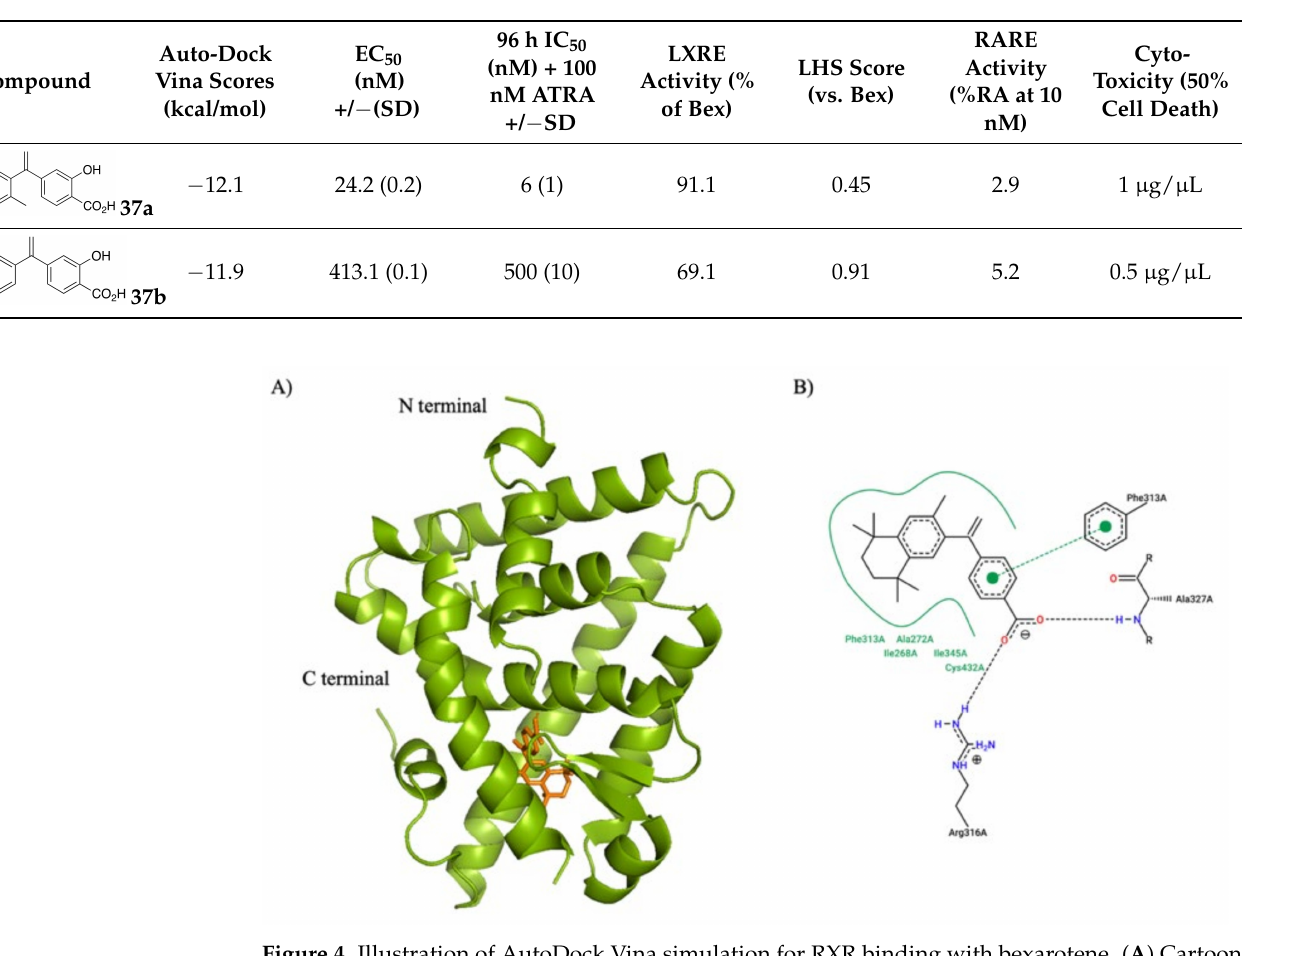
Figure 4. Illustration of AutoDock Vina simulation for RXR binding with bexarotene. ( A ) Cartoon representation of the human RXR alpha ligand binding domain (PDB:1FBY) in green and the com- pound bexarotene in orange. N and C terminals are labeled. ( B ) 2-dimentional depiction of the interactions between protein residue sidechains with bexarotene using PoseView (BioSolvIT). Hydro- gen bonds are presented as dashed lines between interaction partners, and hydrophobic interactions are depicted as smooth contour